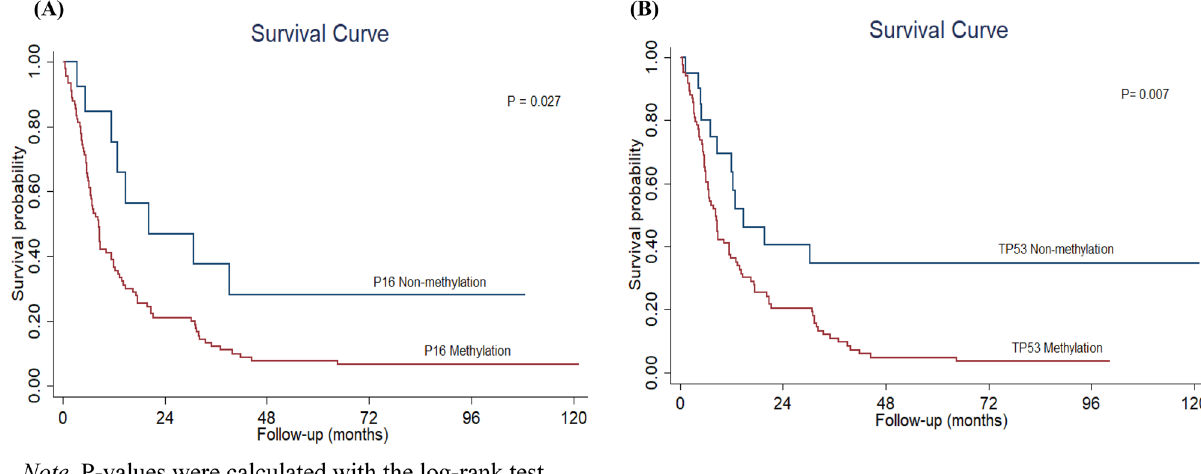
Figure 1. Kaplan–Meier Survival Curves of the Association Between P16 ( A ) and TP53 ( B ) Methylation and EC Prognosis. Note. P -values were calculated with the log-rank